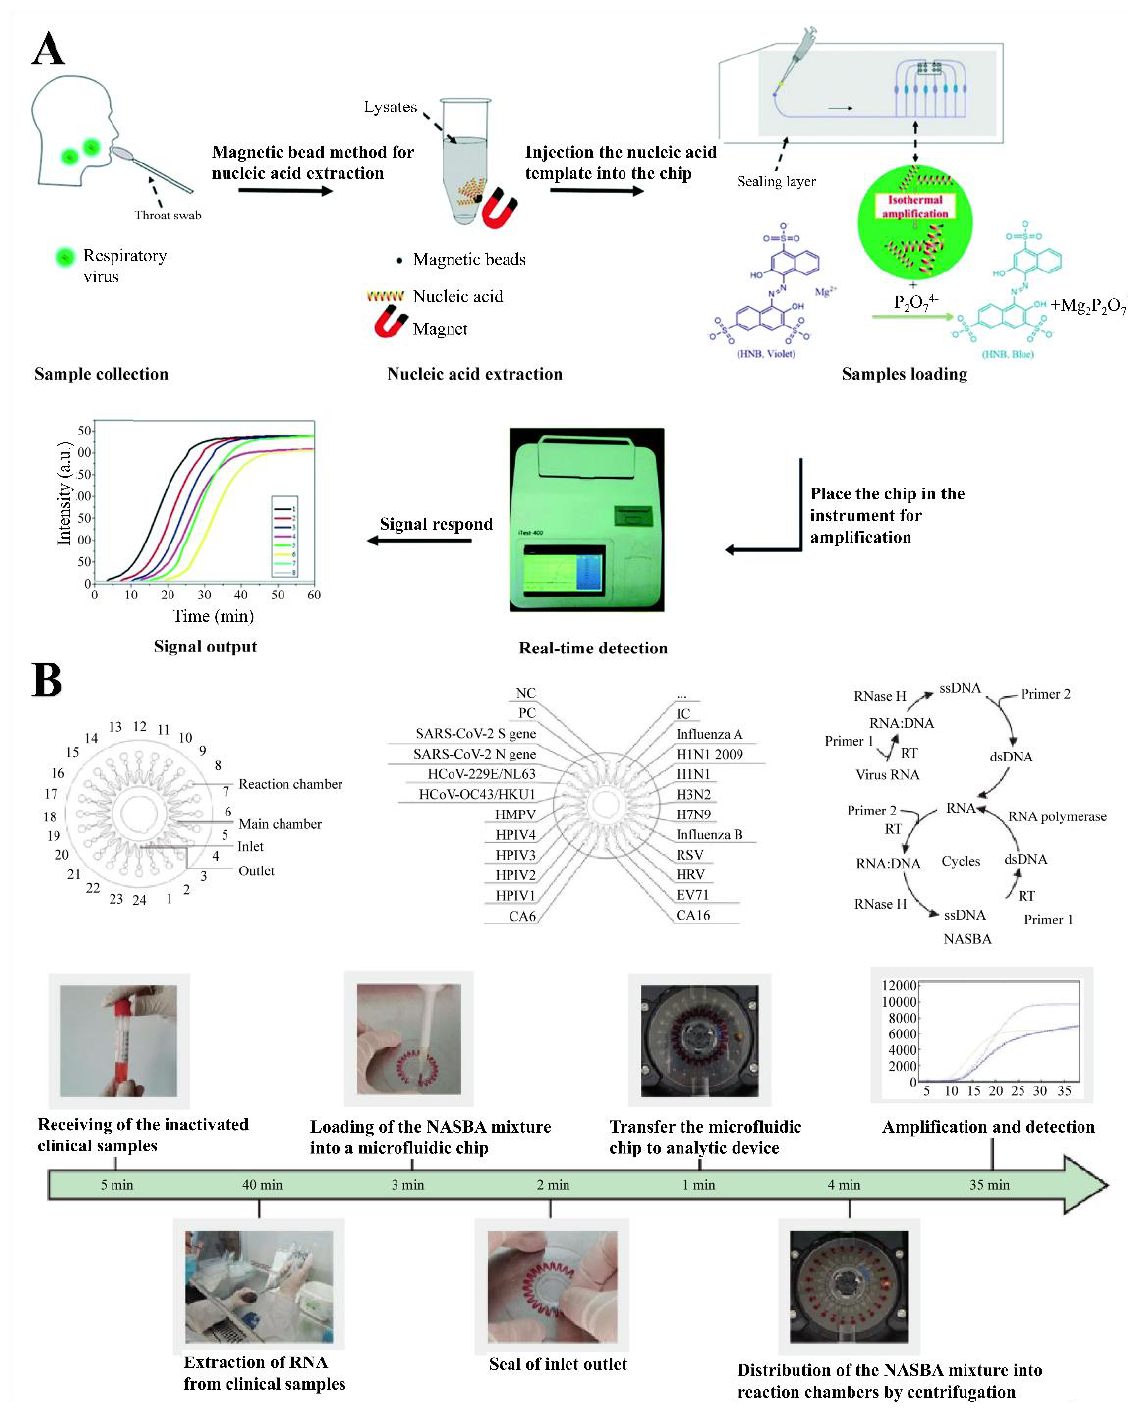
Figure 4. Microfluidic device for respiratory virus detection. ( A ) Schematic diagram of the LAMP-integrated microfluidic chip system for multiplexed respiratory virus detection (LMCS-MRVAs) (reproduced with [55]. Copyright 2018, Royal Society of Chemistry). ( B ) Schematic of the disc-shaped microfluidic device (reproduced with [57]. Copyright 2020, Elsevier).